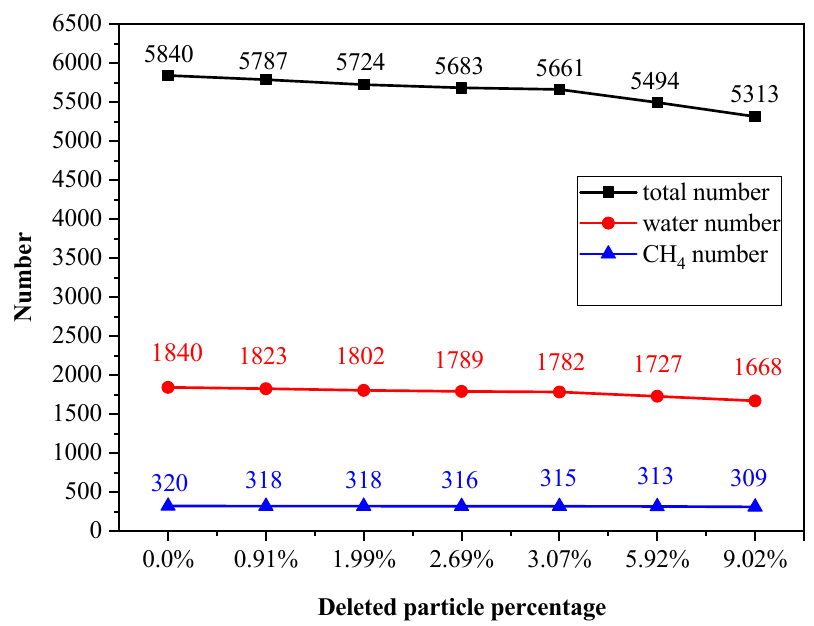
Figure 5. Deletion percentage of system particles for 2 × 2 × 10 unit cells of sI methane hydrate.